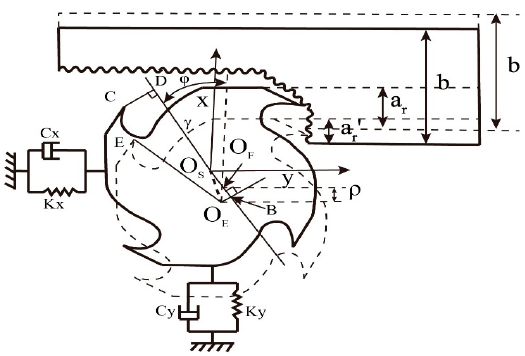
Figure 5. Milling model of thin-walled workpiece considering deformation.